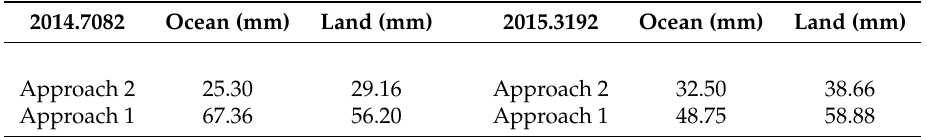
Table 1. Mean of the standard deviation of differences between the reconstructed values and the original GRACE TWSC–terrestrial water storage changes data over the 33 major river basins (marked as land) and rest of the globe (marked as